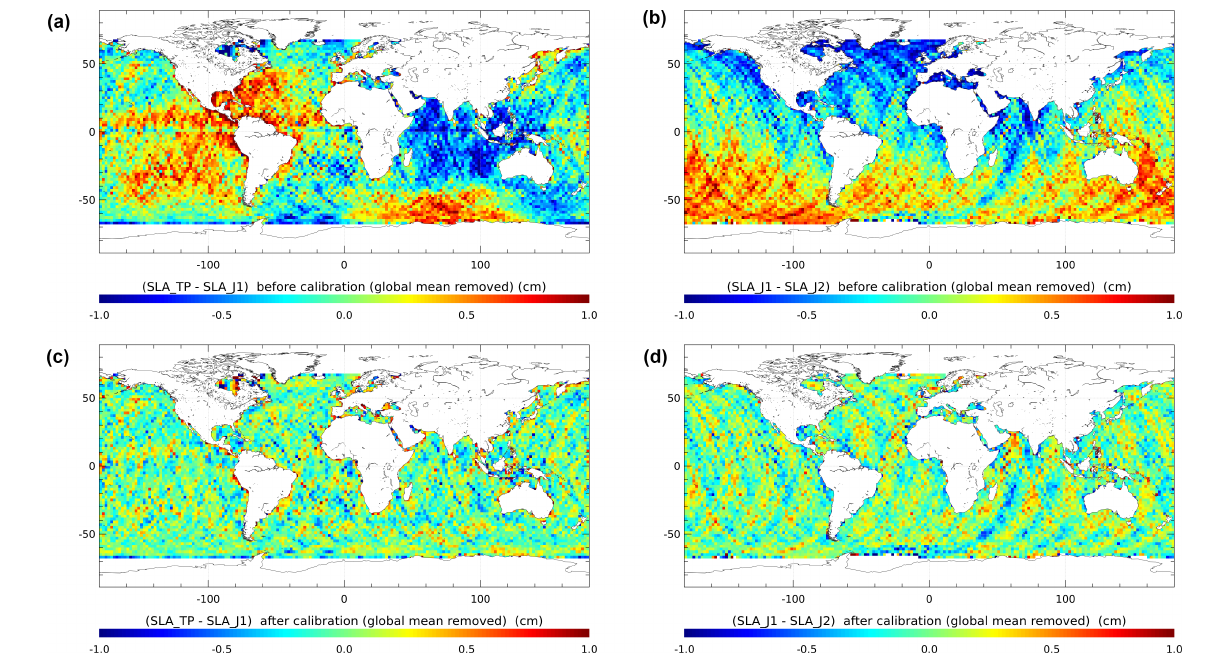
Figure 2. Regional SLA biases observed between TP and J1 during cycles 1 to 21 of J1 before (a) and after (c) reduction of biases. Regional SLA biases observed between J1 and J2 during cycles 1 to 21 of J2, before (b) and after (d) reduction of